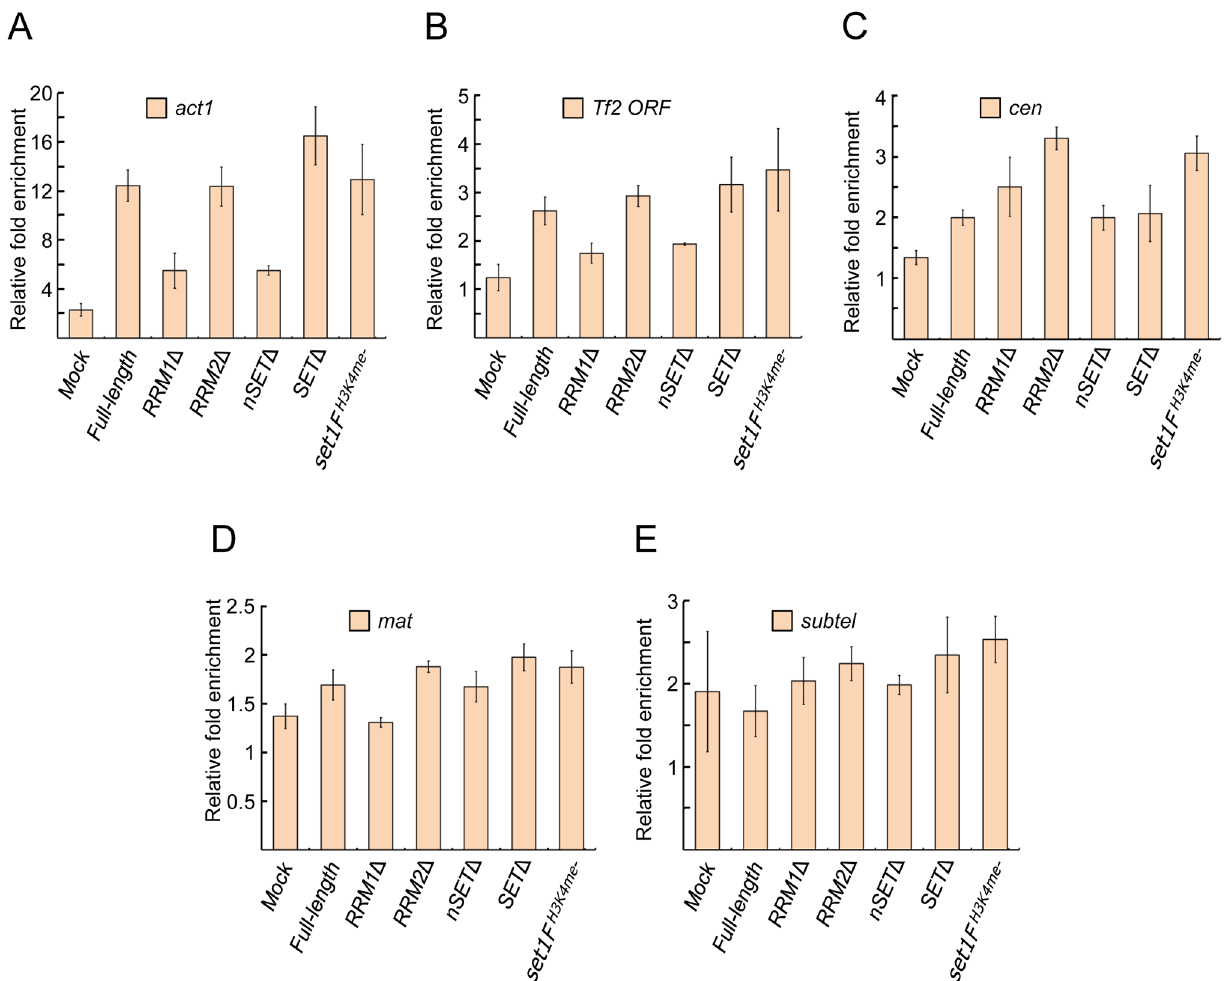
Figure 2. Set1 localization at euchromatic and heterochromatic targets is largely unaffected by certain domain deletions or H3K4me status. Enrichment of Set1 was determined by chromatin immunoprecipitation (ChIP) followed by quantitative PCR (qPCR) using primers targeting (A) the highly expressed actin gene ( act1 ) promoter, (B) the 5 9 end of Tf2 open reading frames, (C) the pericentromeric dg repeat of chromosome II ( cen ), (D) the silent mating type cenH ( mat ), and (E) the chromosome I subtelomeric prl70 ( subtel ). Mock denotes untagged wildtype Set1 strains. Percent enrichment of target amplification compared to input (whole cell extract) was calculated using the 2 2 DD Ct method following normalization by primers targeting mitochondrial DNA (see Materials and Methods). (s.d., error bars; n=2 biological 6 2 qPCR